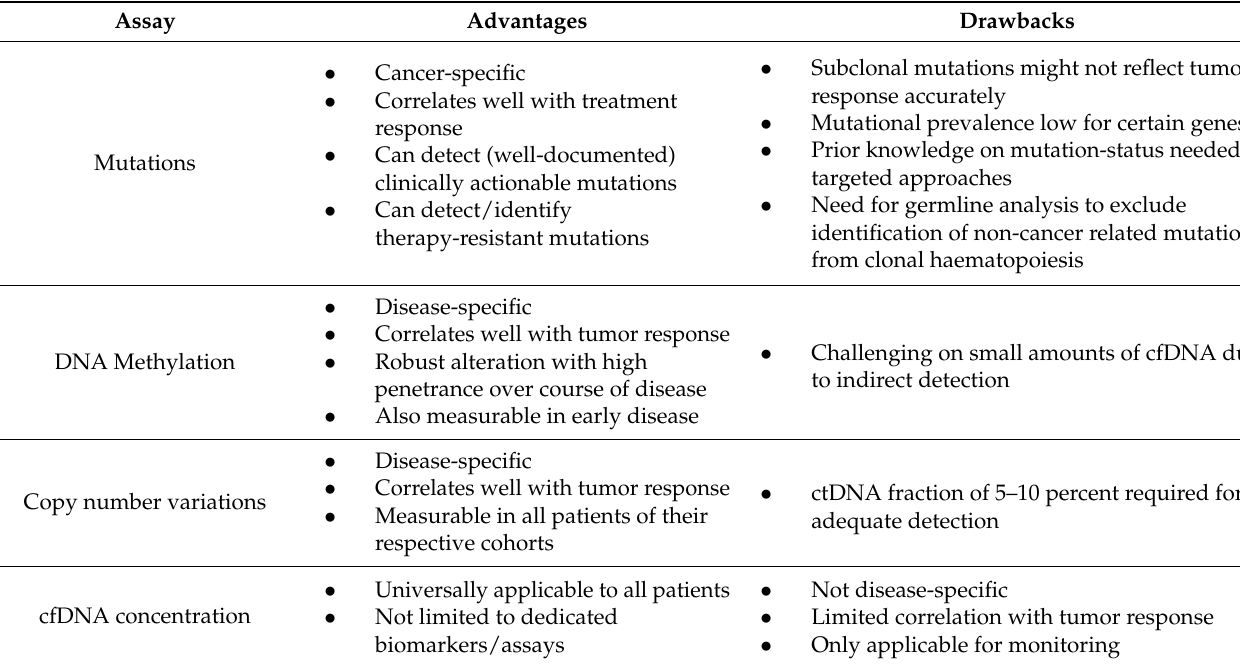
Table 2. Advantages and drawbacks of different cfDNA